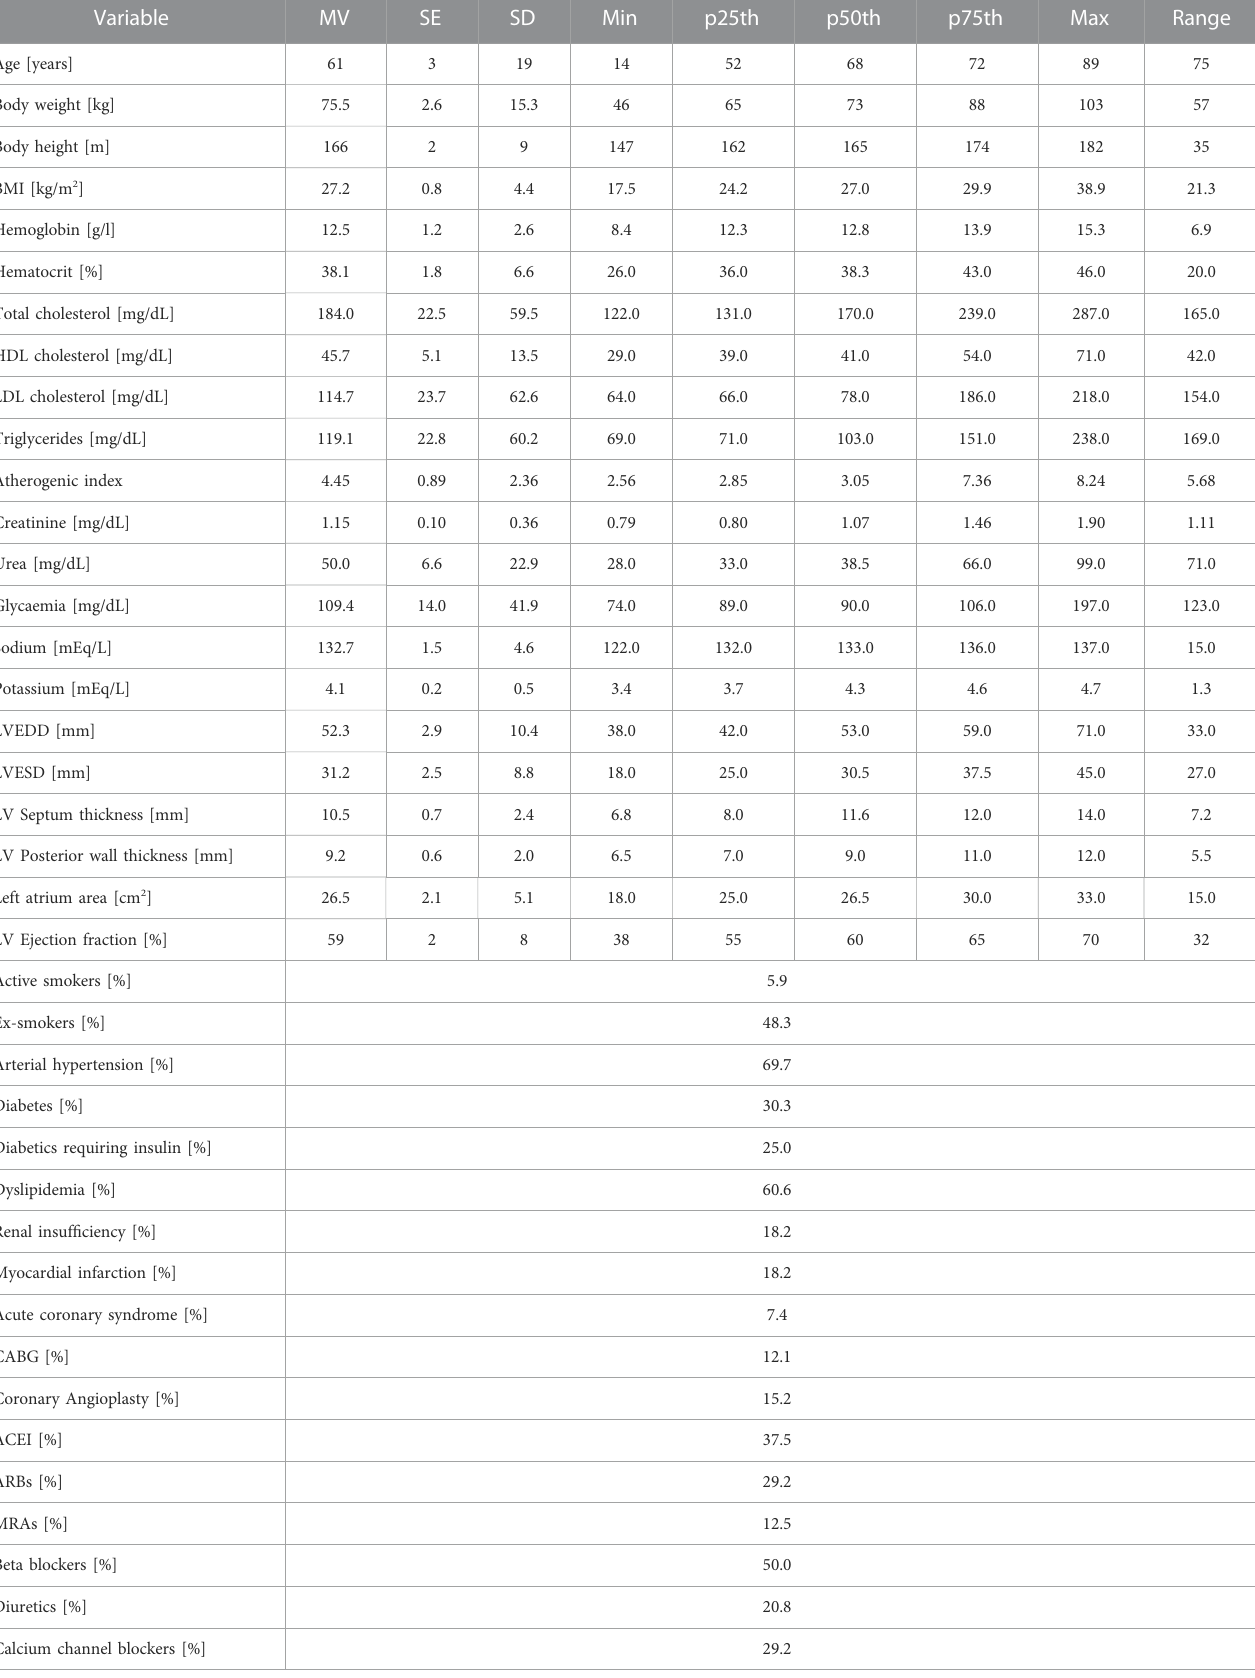
TABLE 1 Demographic, anthropometric and clinical characteristics of the study population. Variable MV SE SD Min